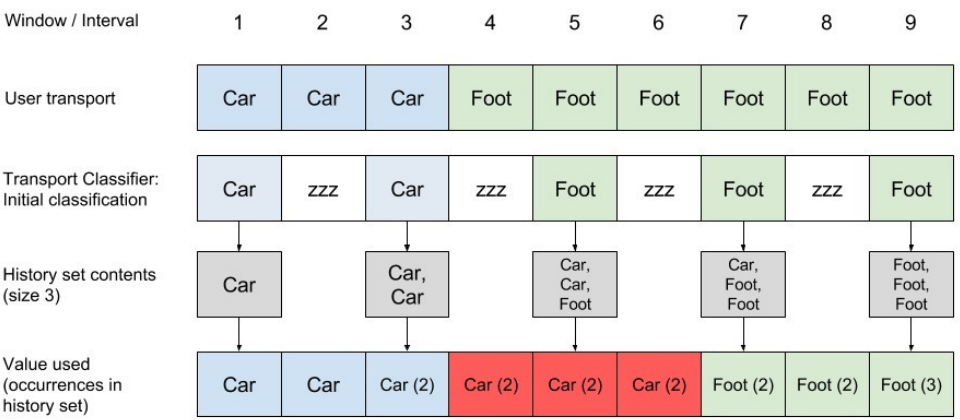
Figure 4. Historical set with alternate sleep sessions.